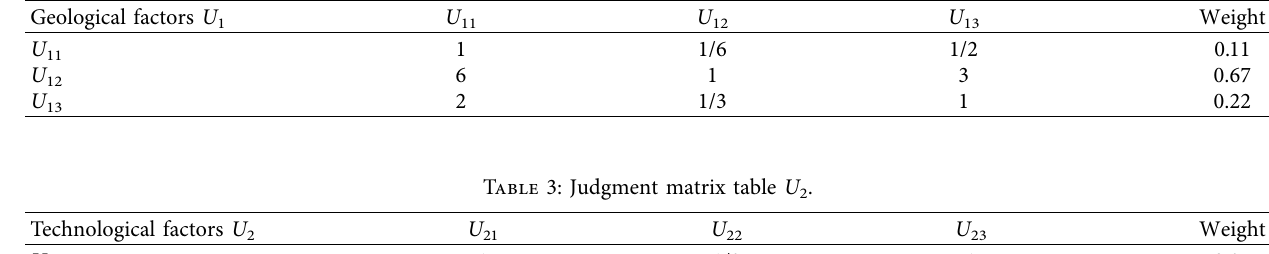
Table 2: Judgment matrix table U